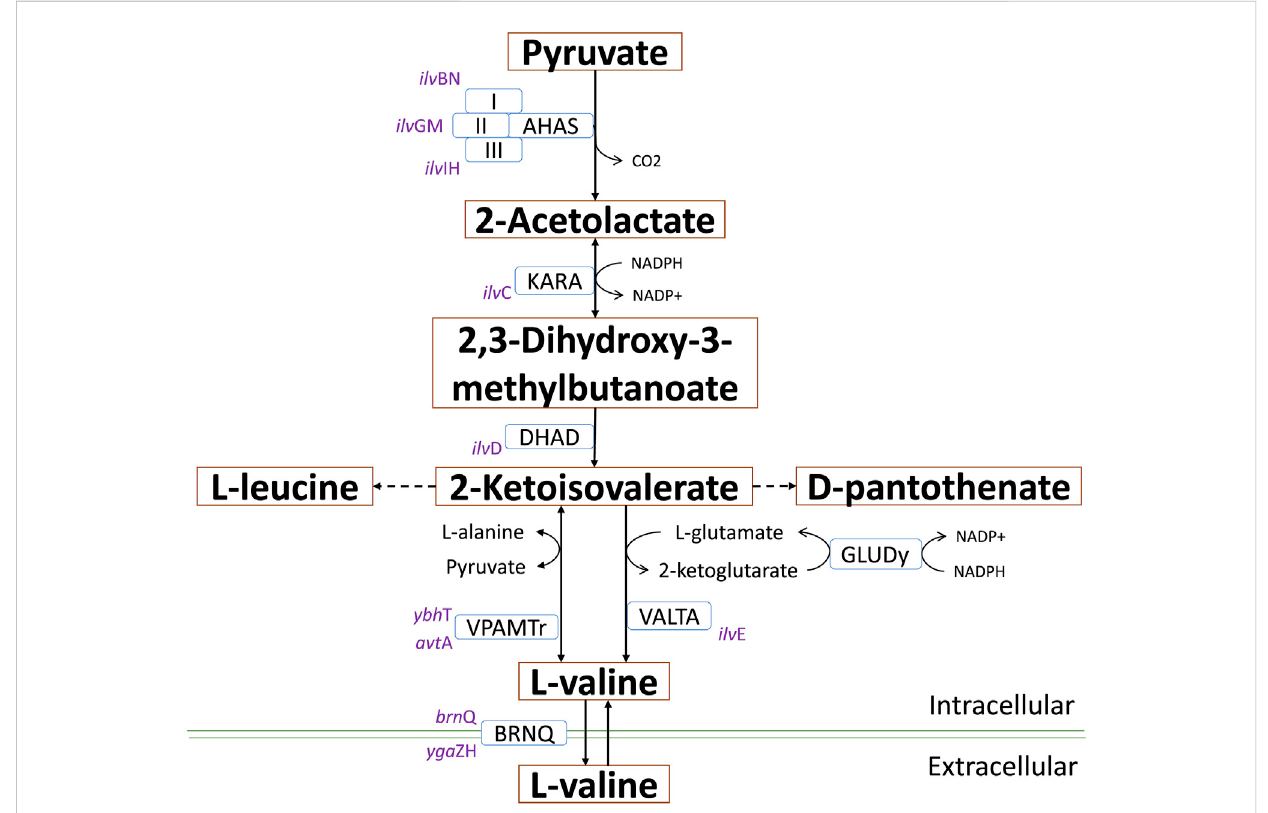
FIGURE 1 L-valine biosynthesis in E. coli via 2-KIV. Acetohydroxyacid synthase (AHAS), ketol-acid reductoisomerase (AHAIR), dihydroxyacid dehydratase